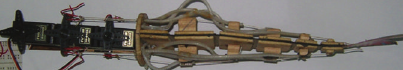
Figure 14: The three servomotors are attached with superglue (Cyanoacrylate glue) to themselves. Superglue was also used for the main bond between them and the wooden tail base with Araldite glue (Epoxy) acting as bulk support (being more voluminous).